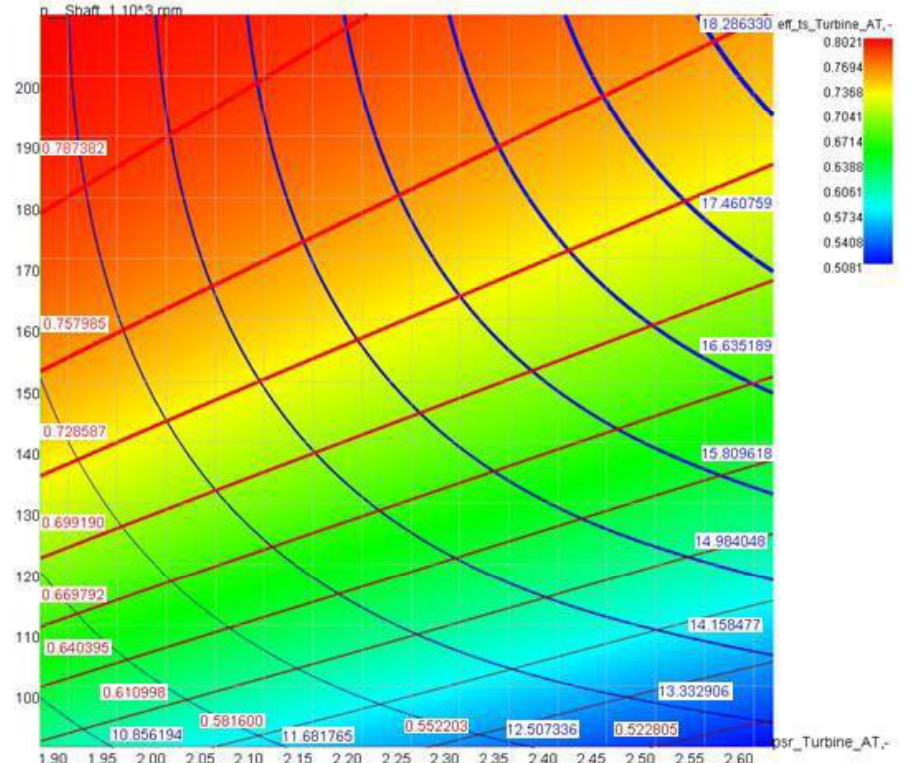
Figure 19. 3D Range 2 turbine map ( y -axis: shaft speed in rpm (1000 s); x -axis: turbine pressure ratio). The legend at the top right-hand side indicates the range of total-to-static turbine efficiency.